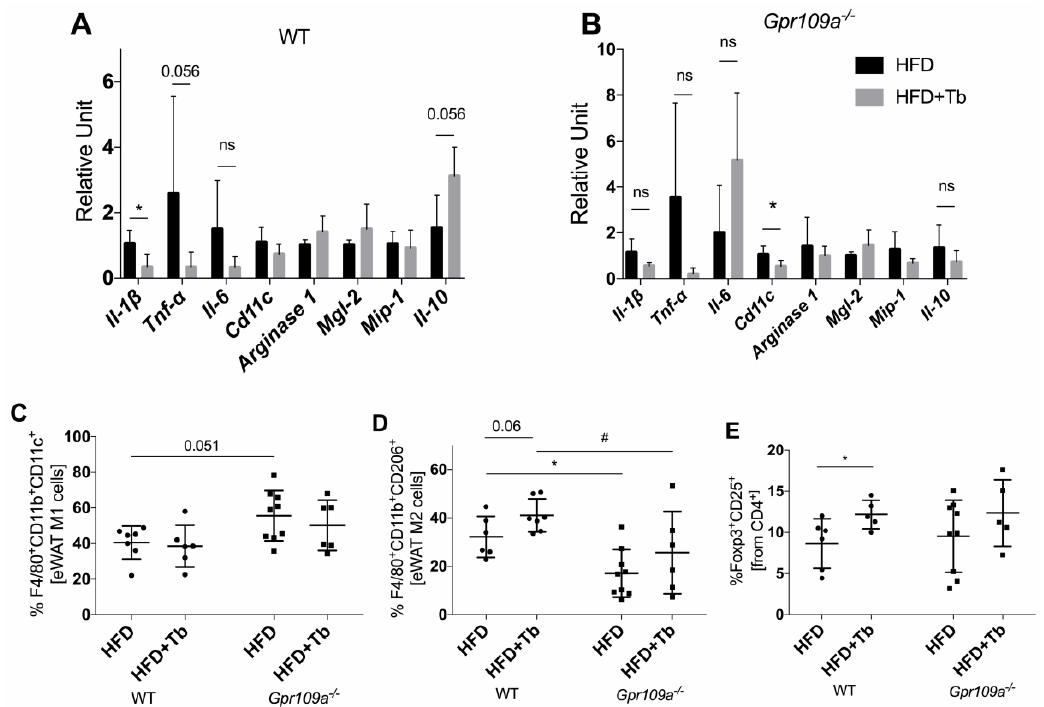
Figure 7. Tb attenuated the inflammation in WAT of obese WT mice through a GPR109A-dependent mechanism. ( A , B ) Effect of Tb treatment on the mRNA expression of inflammatory markers and cell markers ( n = 4, 5 mice per group). * p < 0.05 HFD vs. HFD + Tb. Not significant (ns). ( C ) Frequency of F4 / 80 + CD11b + CD11c + M1 macrophages in WAT of obese mice treated or not with Tb ( n = 6–9 mice per group). ( D ) Frequency of F4 / 80 + CD11b + CD206 + M2 macrophages in WAT of obese mice treated or